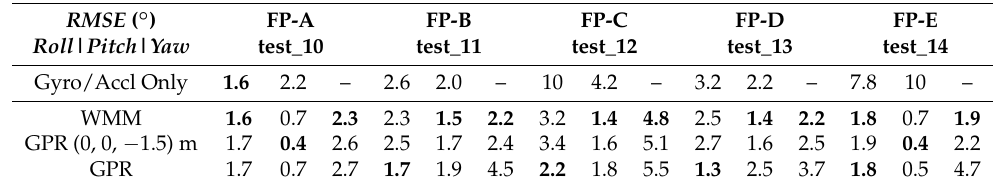
Table 4. RMSE for each outdoor experimental test using different magnetic field reference sources. The first row excludes magnetometer data. For each test, the three columns show the RMSE for roll, pitch, and yaw, respectively, in degrees.